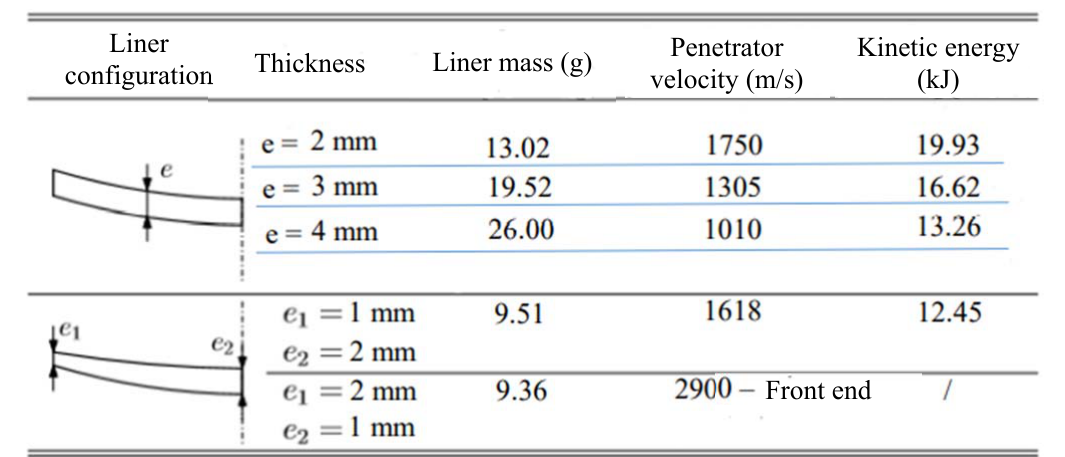
Table 4. Different geometries of EFP copper made liner